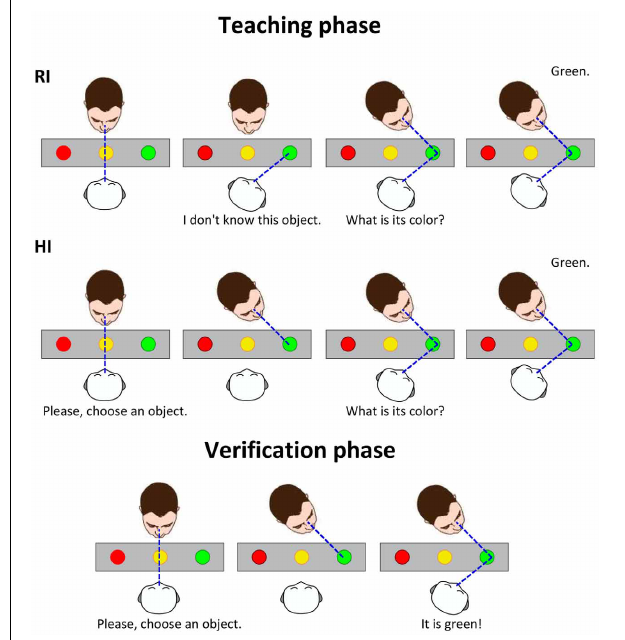
FIGURE 2 | Schematic representation of the events in the experimental protocol. Two different conditions are tested for the teaching phase . RI : The robot initiates the phase by looking at a random object. The human, if engaged, naturally looks back at the common object of interest. When both partners look at the object, the robot asks the color of the object, and the human answers. HI : The human initiates the phase by looking at a desired object. The robot tracks the human head movement, then guesses which object is being observed by the human. It asks about the color of the object, which is answered by the human. The color label is then associated to the object’s prominent color feature. In the verification phase , the human validates if the robot correctly learned the object colors. The human looks randomly at some objects. The robot tracks the human gaze, estimates the object of interest, retrieves the color label learned in the teaching phase and says the color to the